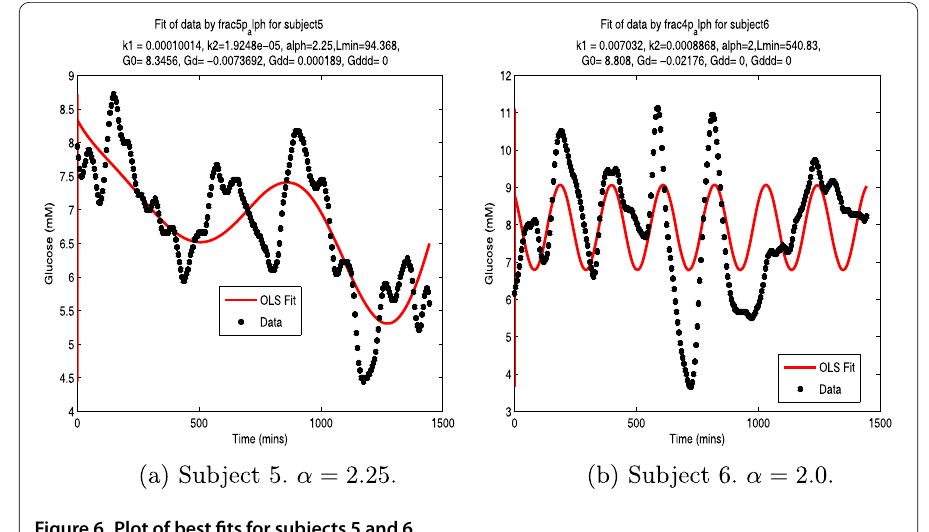
Figure 6 Plot of best fits for subjects 5 and